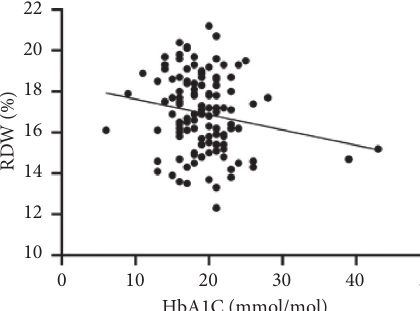
Figure 10: Relation between MCHC and HbA1c ( r � 0.02; p � 0 .